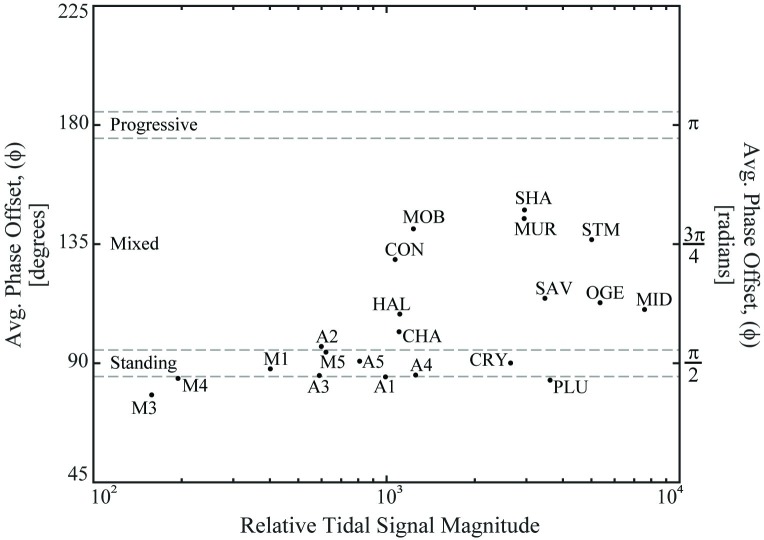
Range of tidal fourier transform magnitudes vs. velocity phase offsets (ϕ) across sites.Site labels are the same as those in Table 1. To enable comparison among sites, the Relative Tidal Signal Magnitude represents the maximum power spectrum magnitude observed during each site’s FFT analysis. Although the variable is unitless, this variable serves as a proxy for the maximum tidal harmonic amplitude (i.e., larger magnitudes ~ larger amplitudes). However, this metric is used for illustration purposes and aides in the graphical differentiation of each site, but the variable does not completely represent the multiple important tidal harmonics at each site. Visualization created using MATLAB software.